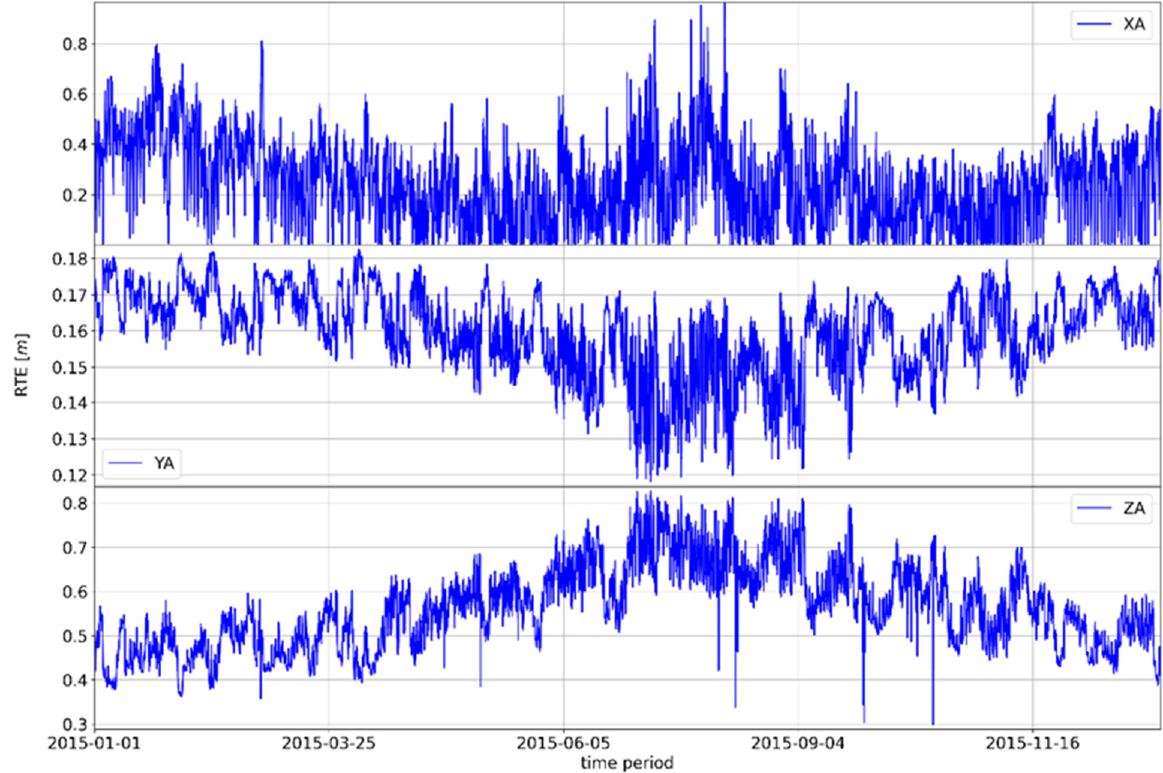
Remote Sens. 2023 , 15 , x FOR PEER REVIEW Figure A2. Movement of the absolute difference of the RTE GNSS Zadar position parameter in 2015.